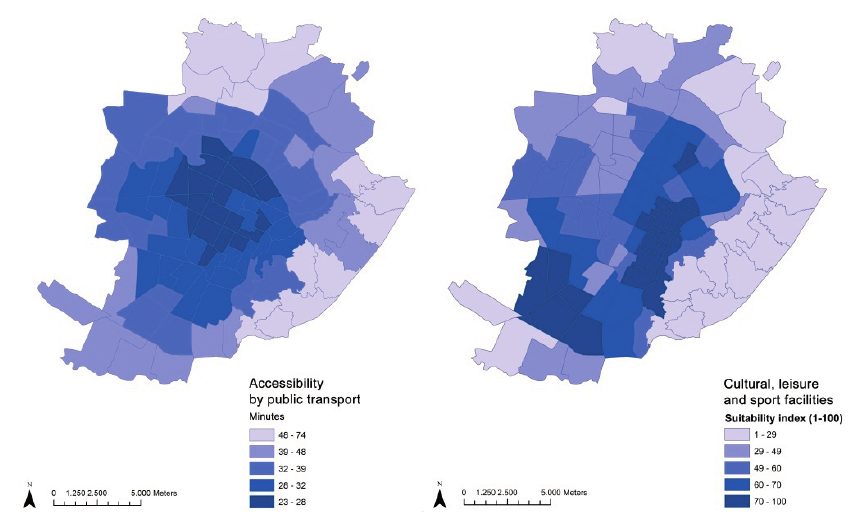
Figure 2. Distribution of BE availability of